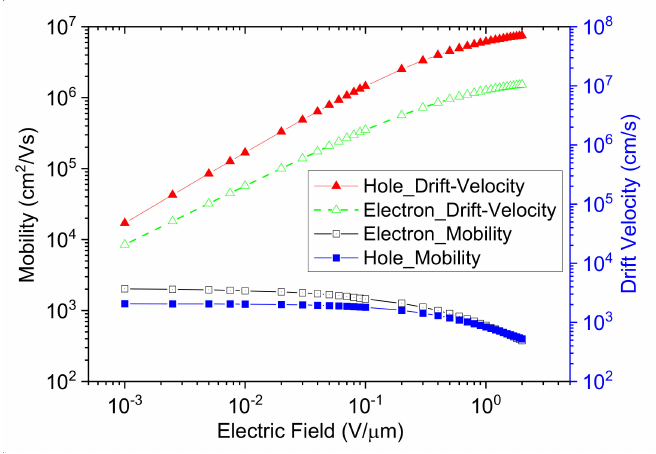
Figure 7. Drift velocity (right axis) and mobility (left axis) for electrons and holes as calculated using Equation (3) and Equations (3) and (4),